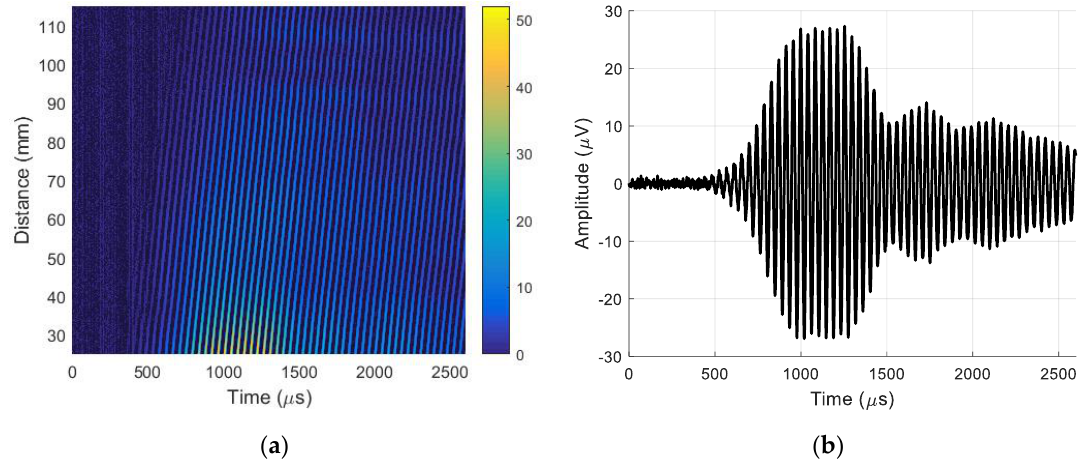
Figure 19. ( a ) B-scan recorded by a single air-coupled ultrasonic transducer before filtering. ( b ) A-scan signal taken from the B-scan before filtering at distance of 37.5